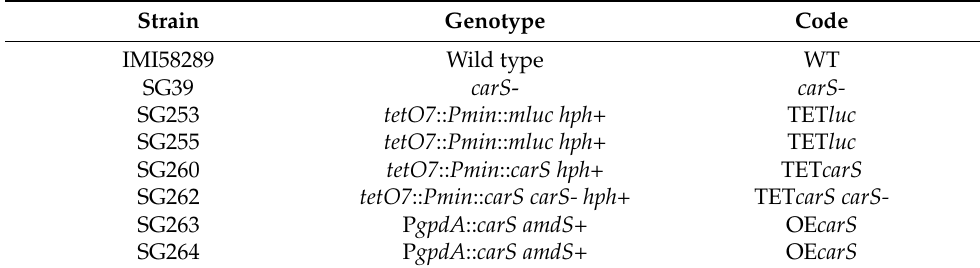
Table 1. Strains used in this